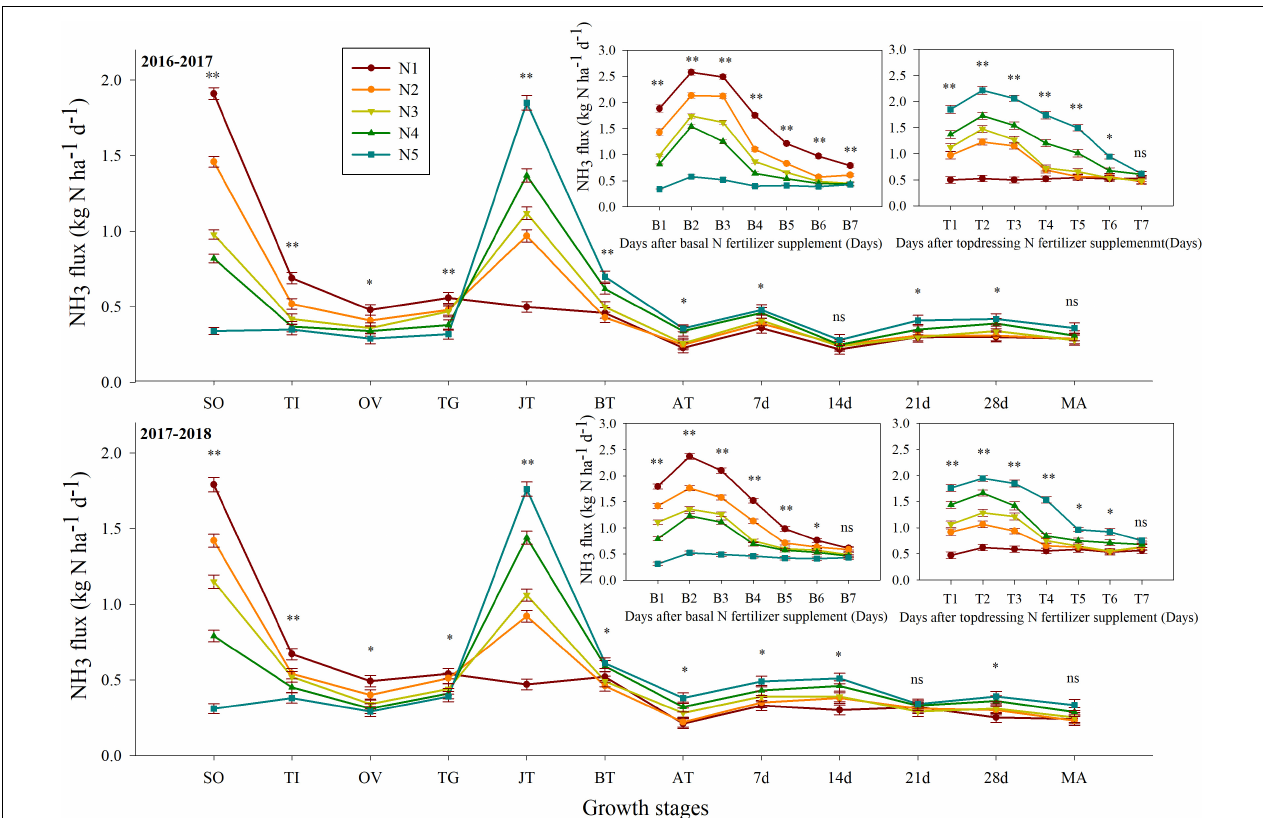
FIGURE 1 | Effect of split nitrogen fertilizer on NH 3 flux. B1, B2, B3, B4, B5, B6, B7 is the 1, 2, 3, 4, 5, 6, 7 days after basal nitrogen fertilizer supplement; and T1, T2, T3, T4, T5, T6, T7 is the 1, 2, 3, 4, 5, 6, 7 days after topdressing nitrogen fertilizer supplement. ∗ , ∗∗ significant at the 0.05 and 0.01 probability levels, respectively, ns, no significant. N1 (basal/dressing, 100/0%), N2 (basal/dressing, 70/30%), N3 (basal/dressing, 50/50%), N4 (basal/dressing, 30/70%), and N5 (basal/dressing, 0/100%).